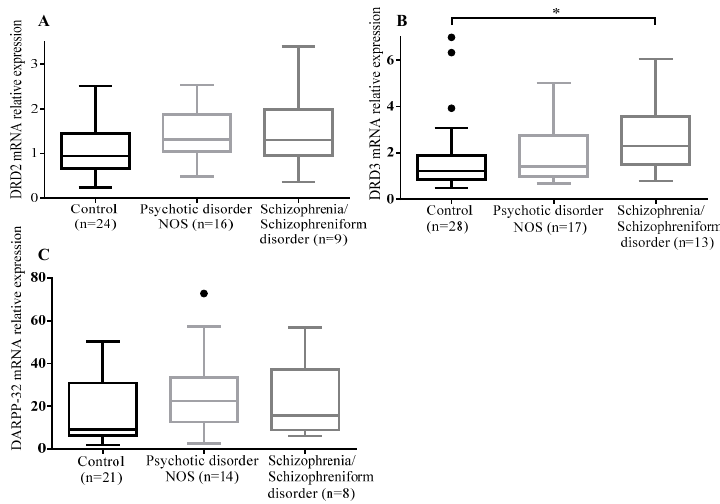
Figure 1. Comparison of DRD2 , DRD3 , DARPP-32 mRNA levels among the three groups: ( A )